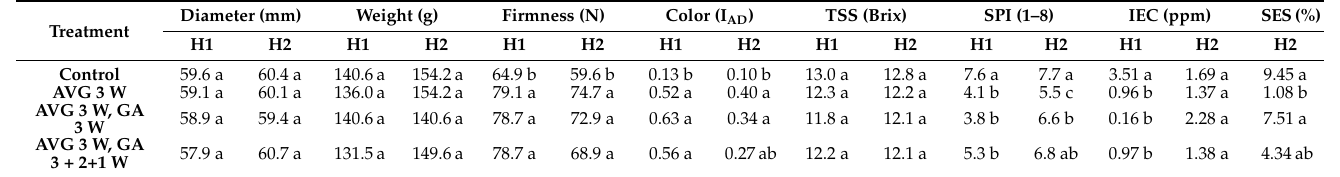
Table 4. Effects of AVG and GA 4+7 on fruit quality of ‘Crimson Gala’ apples at harvest, 2021, Exp.